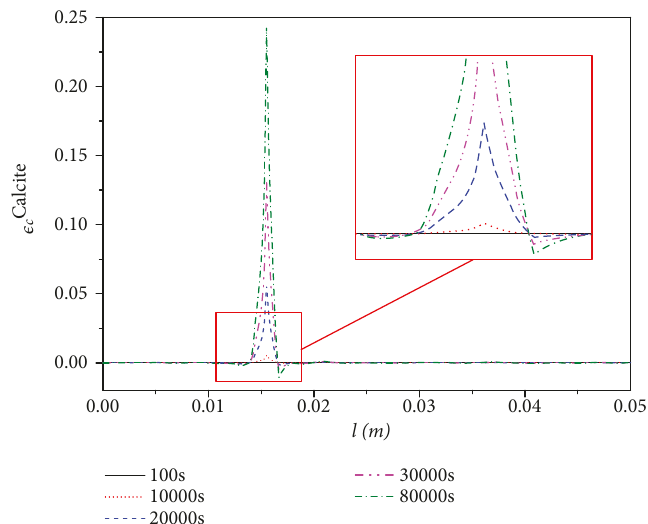
Figure 19: The strain caused by calcite dissolution/precipitation along transect 1.